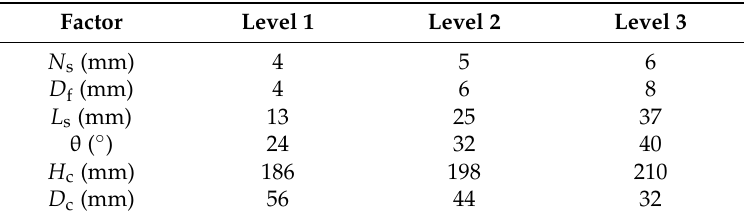
Figure 2. Reverse ‐ circulation drilling apparatus based on supersonic nozzle. 1. Air outlet; 2. Top joint; 3. Center passage; 4.Seal ring; 5. Supersonic nozzle; 6. Outer shell; 7.Flushing nozzle; 8. Bit crown; 9.Air vent; 10. Work bench; 11. Air inlete. Table 1. Factors and levels for L 27 (3 13 ) orthogonal array.